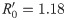
Surveillance data of the compartments for Disease 1 equilibrium.The reproduction number of the original strain is R0 = 3.33, while the reproduction number of the emergent strain is R0′=1.18. The vaccination rate used is 0.5.